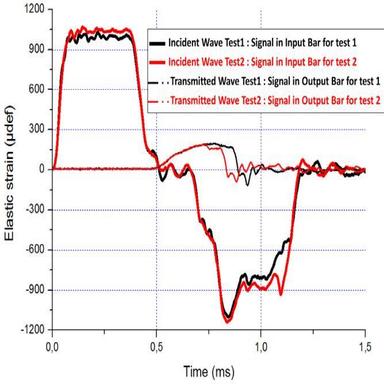
Raw signals from SHTB tests.